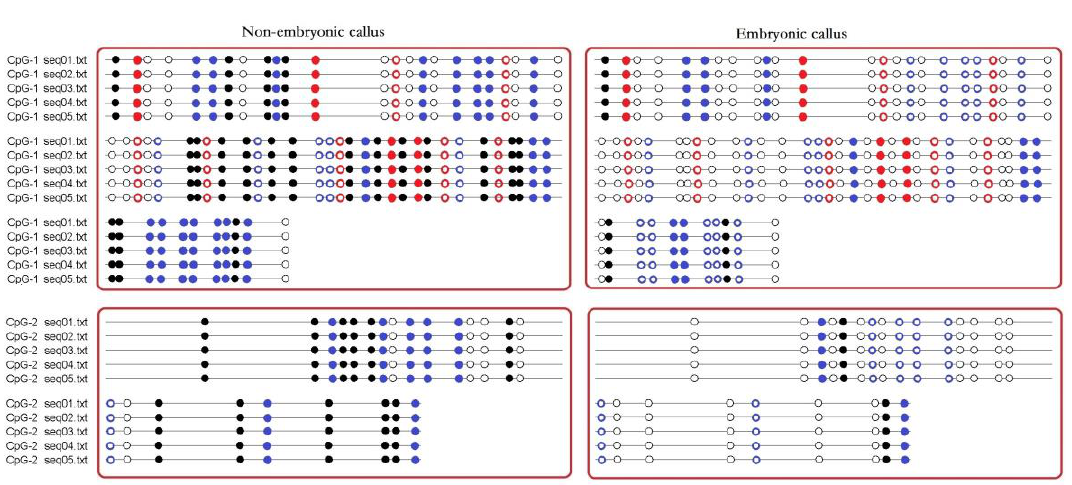
Figure 2. Schematic diagram of CpG promoter methylation sites in AcSERK1 . Black dots represent methylated CG sites, and white dots represent unmethylated CG sites. Red dots represent CHG. Blue dots represent CHH. H = A, C, or T. Solid dots represent methylated sites. Hollow dots represent unmethylated sites. The results represent 5 biological replicates (labeled as seq01.txt to seq05.txt).